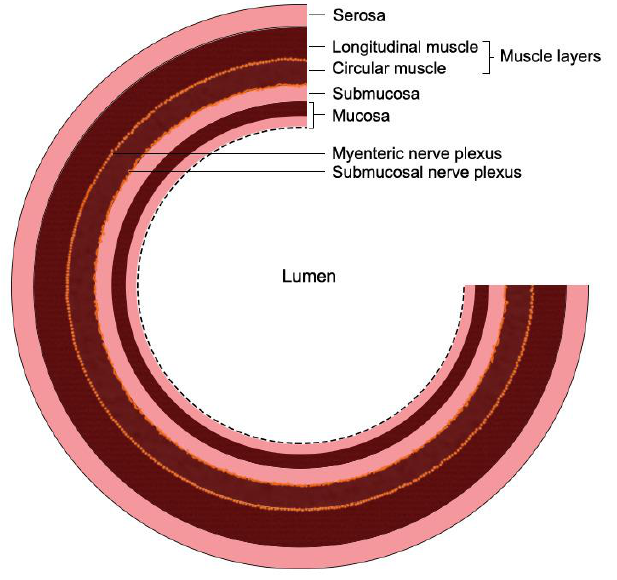
Figure 1. The organization of gut wall